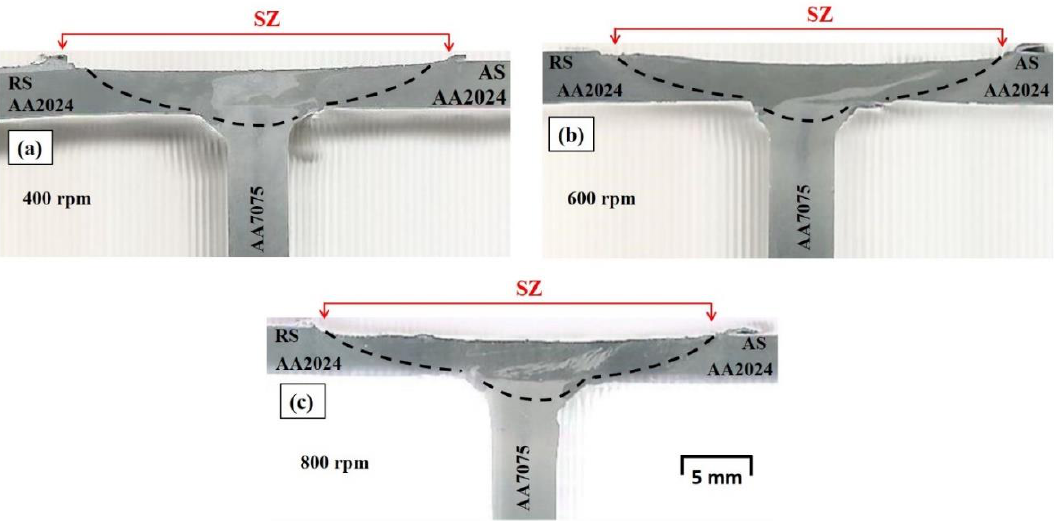
Figure 5. Macrographs of T-butt-joints of friction stir weldedAA2024 and AA7075 at different rotational speeds of ( a ) 400 rpm, ( b ) 600 rpm, and ( c ) 800 rpm.